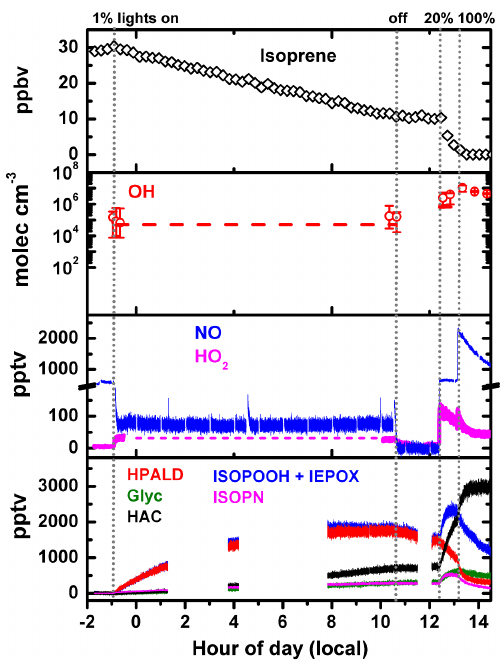
Figure 3. Progress of the slow chemistry experiment performed on 01/07/2014. Isoprene data were provided by GCFID. The red dashed line in the OH plot is the steady-state OH concentra- tion derived from the decay of isoprene as monitored by GC- FID. OH and HO 2 preliminary data were provided by GTHOS, using chemical zeroing, although the steady-state value of (0.4– 1) × 10 5 moleccm − 3 was below the detection limit of GTHOS. OH preliminary data were averaged to reduce noise. NO data were pro- vided by NO–CL and OVOC data were provided by